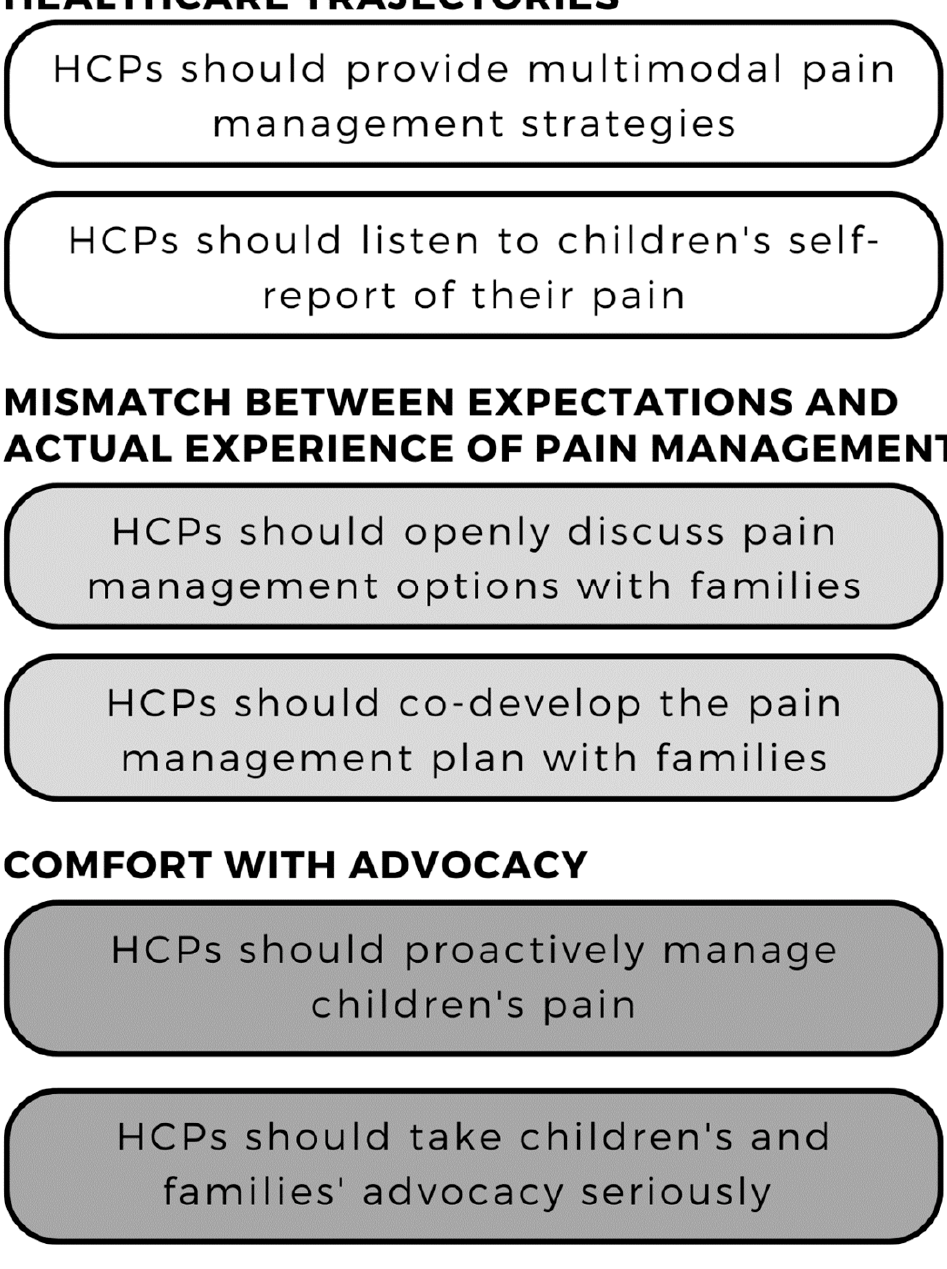
Figure 1. Summary of Implications for Clinical Practice.